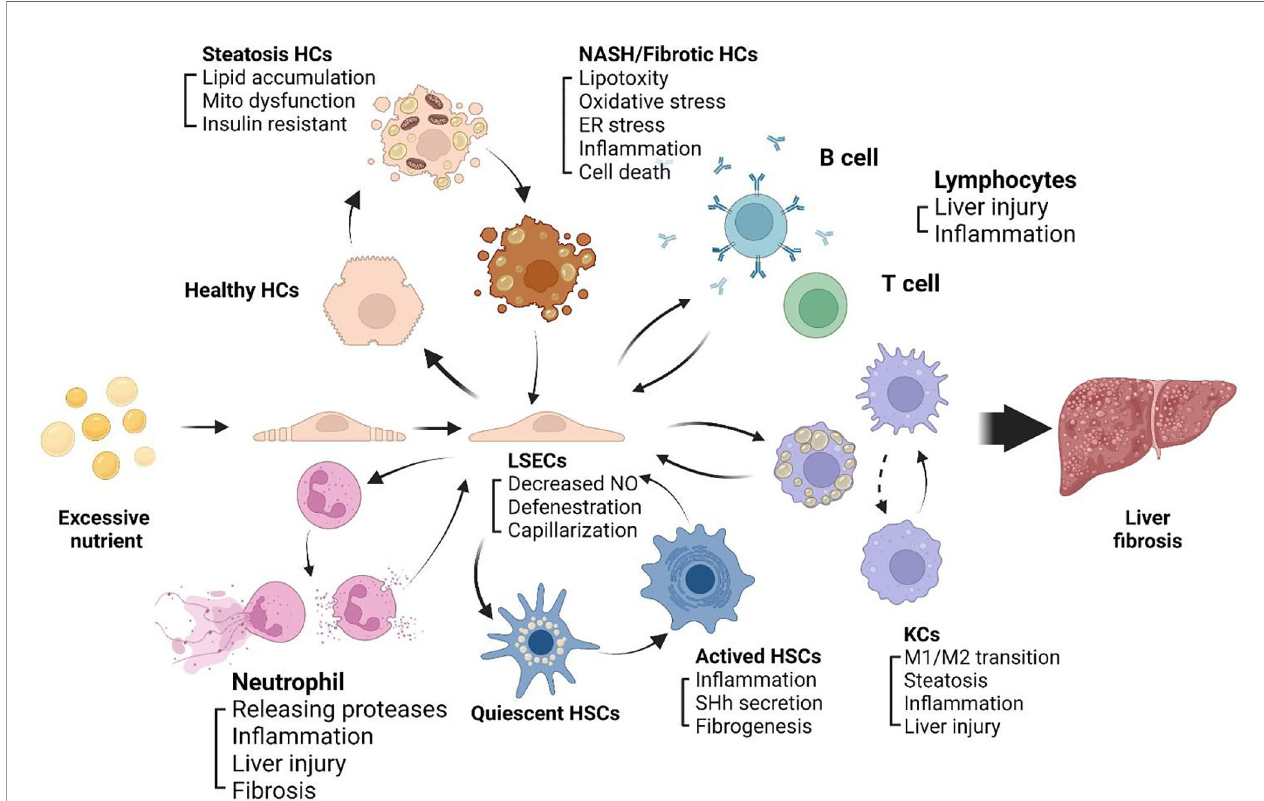
FIGURE 2 | Sinusoidal crosstalk mediated by LSECs play a key role in progression of NASH to liver fi brosis. A series of pathophysiological processes from NASH to liver fi brosis are mediated by LSECs. Capillarization and dysfunction of LSECs appear in early stage of NASH. Capillarized LSECs acquire a pro-in fl ammatory phenotype, recruiting immune cells including neutrophils, monocytes and lymphocytes to the hepatic microenvironment, promoting HCs steatosis and cell death, activating HSCs and KCs, and promoting liver fi